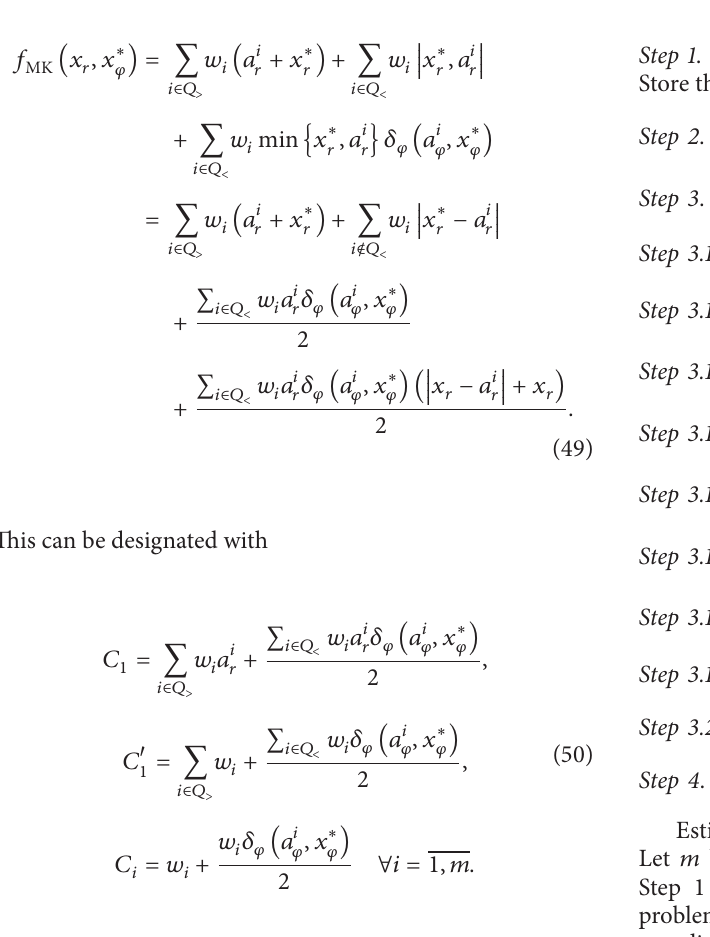
Algorithm 8. Solve the location problem with Moscow- Karlsruhe